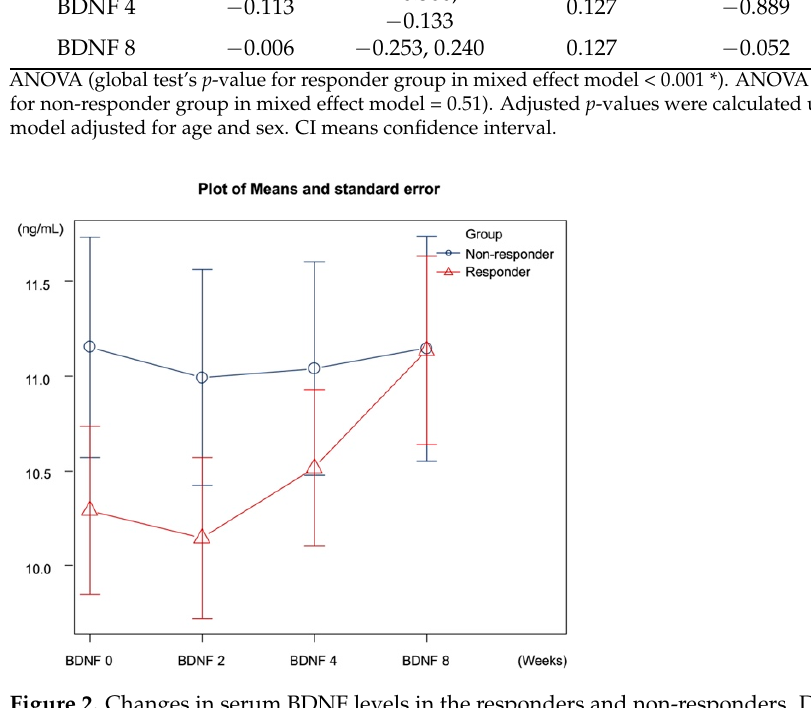
Figure 2. Changes in serum BDNF levels in the responders and non-responders. Data was expressed as mean and standard error.